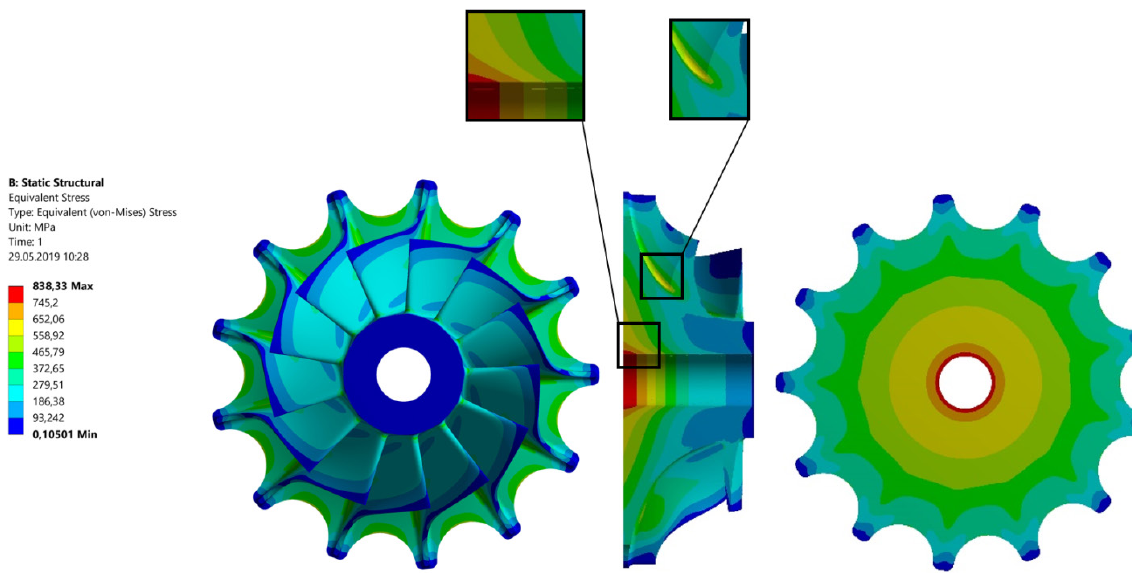
Figure 16: Von Mises stress of turbine disc -optimisation 1(rotational speed – 96,000 rpm; temperature – 600 ∘ C)